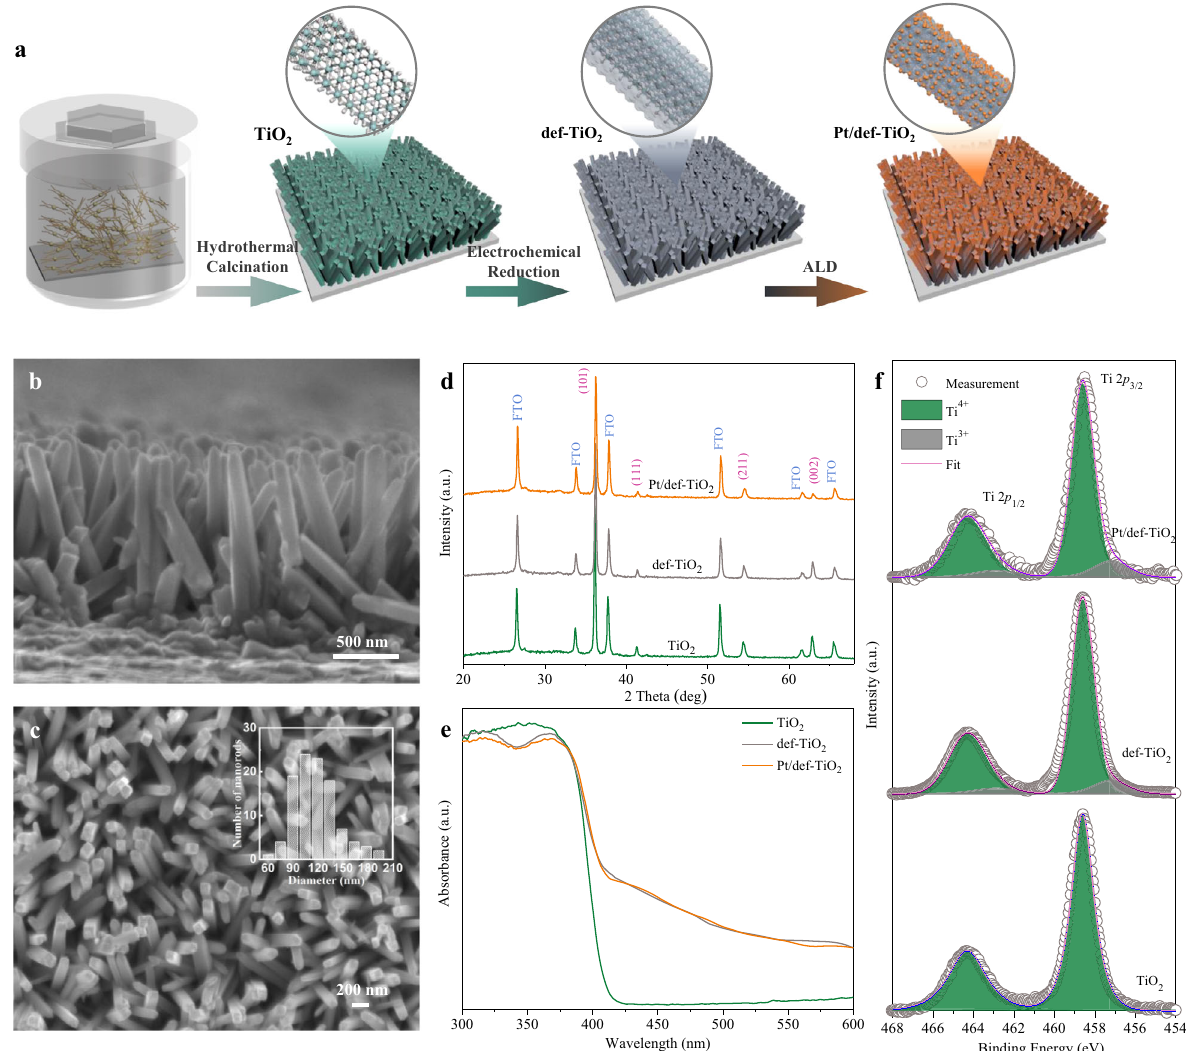
Fig.2|FabricationandcharacterizationoftheNRAswithPtatoms.a Schematic diagram of the fabricating process for the TiO 2 , def-TiO 2 , and Pt/def-TiO 2 NRAs. b Top-view and ( c ) side-view SEM images of the TiO 2 NRAs. Inset: the diameter